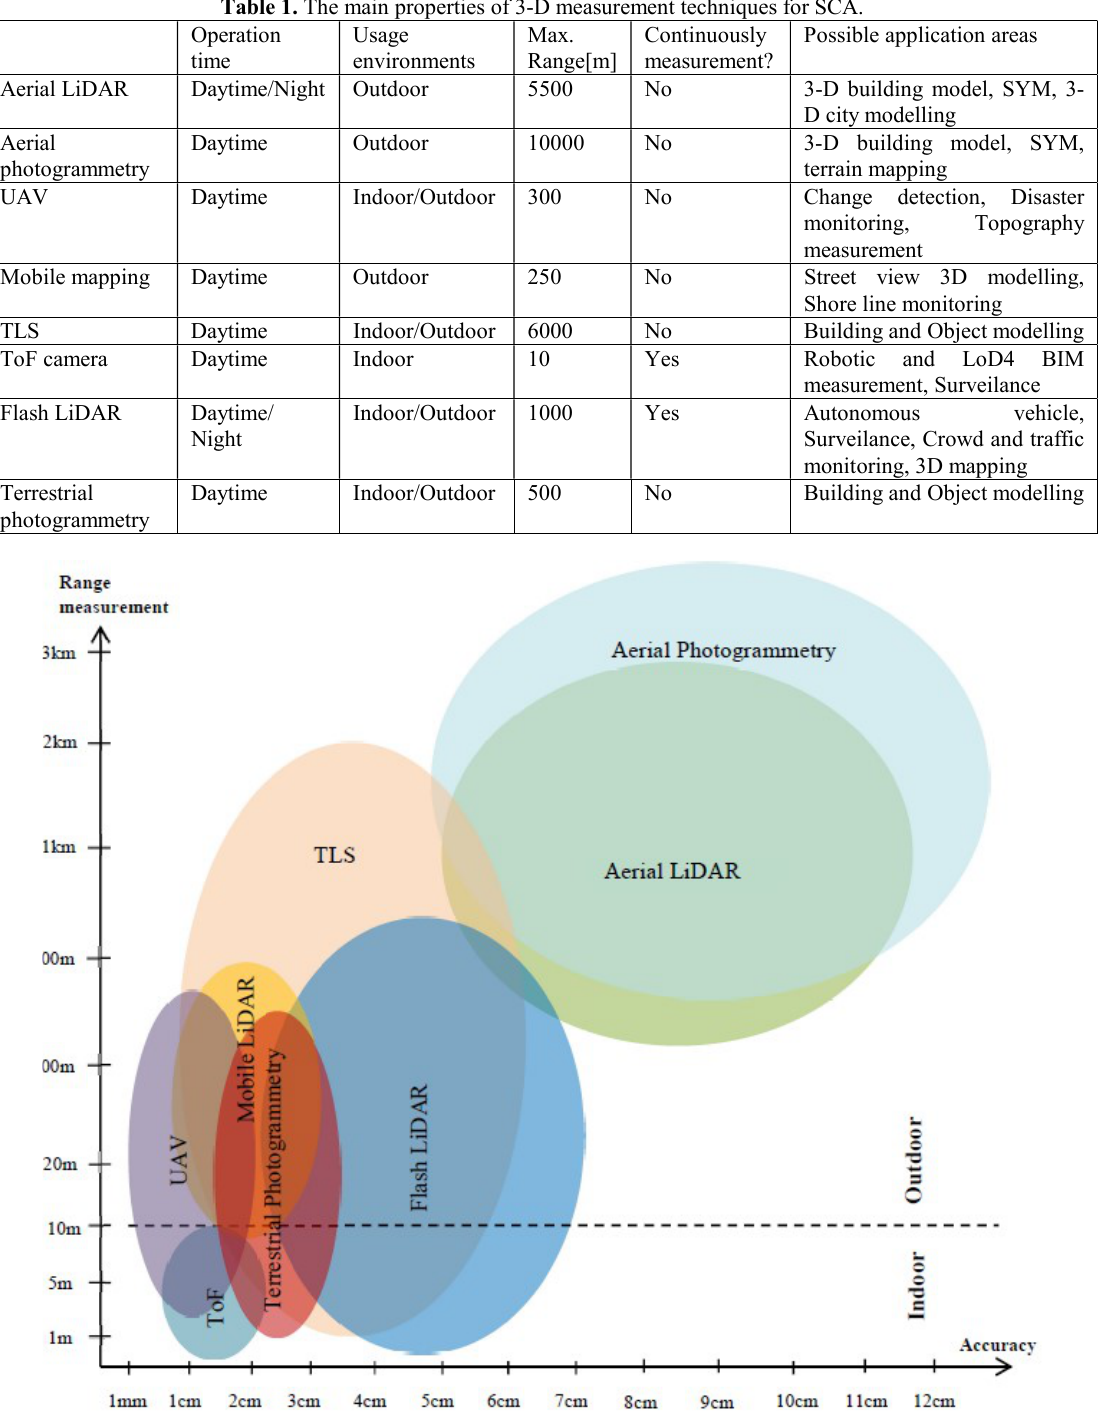
Table 1. The main properties of 3-D measurement techniques for SCA.